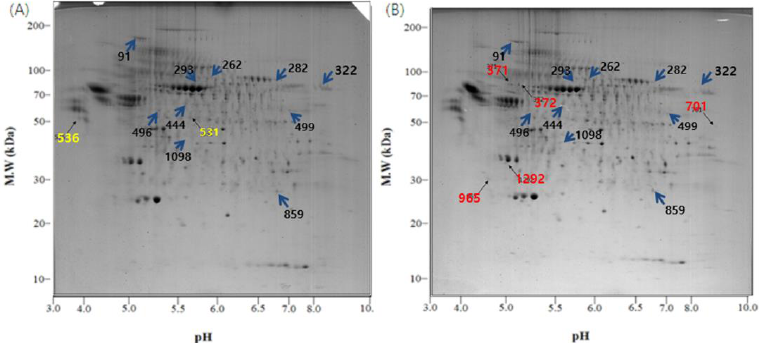
Figure 3. 2-DE gel images of the exosome proteome from U-87MG cells. ( A ) Exosomal proteins from U-87MG cells for 2-DE, which were incubated at 37 ◦ C, 5% CO 2 for 4 days without any change in temperature; ( B ) During the incubation at 37 ◦ C, 5% CO 2 for 4 days, the cells were exposed to 18 ◦ C three times for 30 min, over a period of 36 h in a low temperature incubator (L.T.). Location of significant protein spots on 2-DE gels was represented as arrows. (blue: Spots that exist on both the control and the L.T. gel but express in different intensity; yellow: Spots that exist only on the control gel; red: Spots that exist only on the L.T.